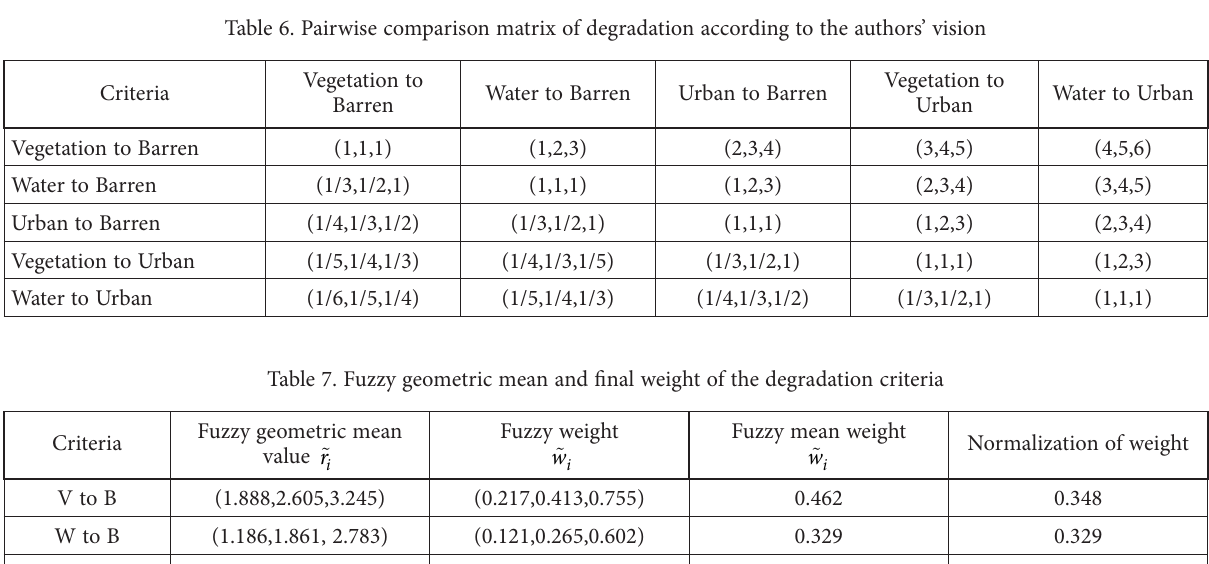
Table 6. Pairwise comparison matrix of degradation according to the authors’ vision Vegetation to Water to Barren Urban to Barren Criteria Barren